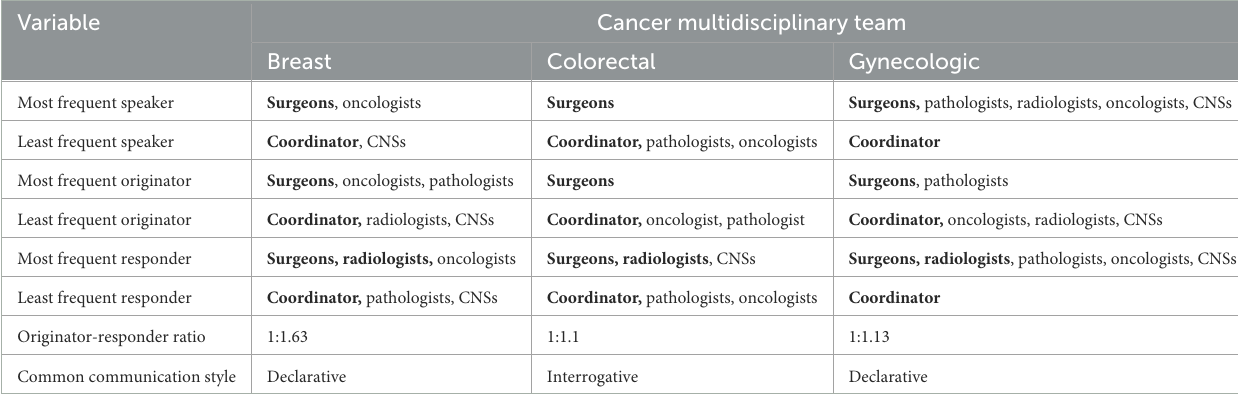
TABLE 5 Overview of similarities and differences in communication among participating cancer multidisciplinary teams